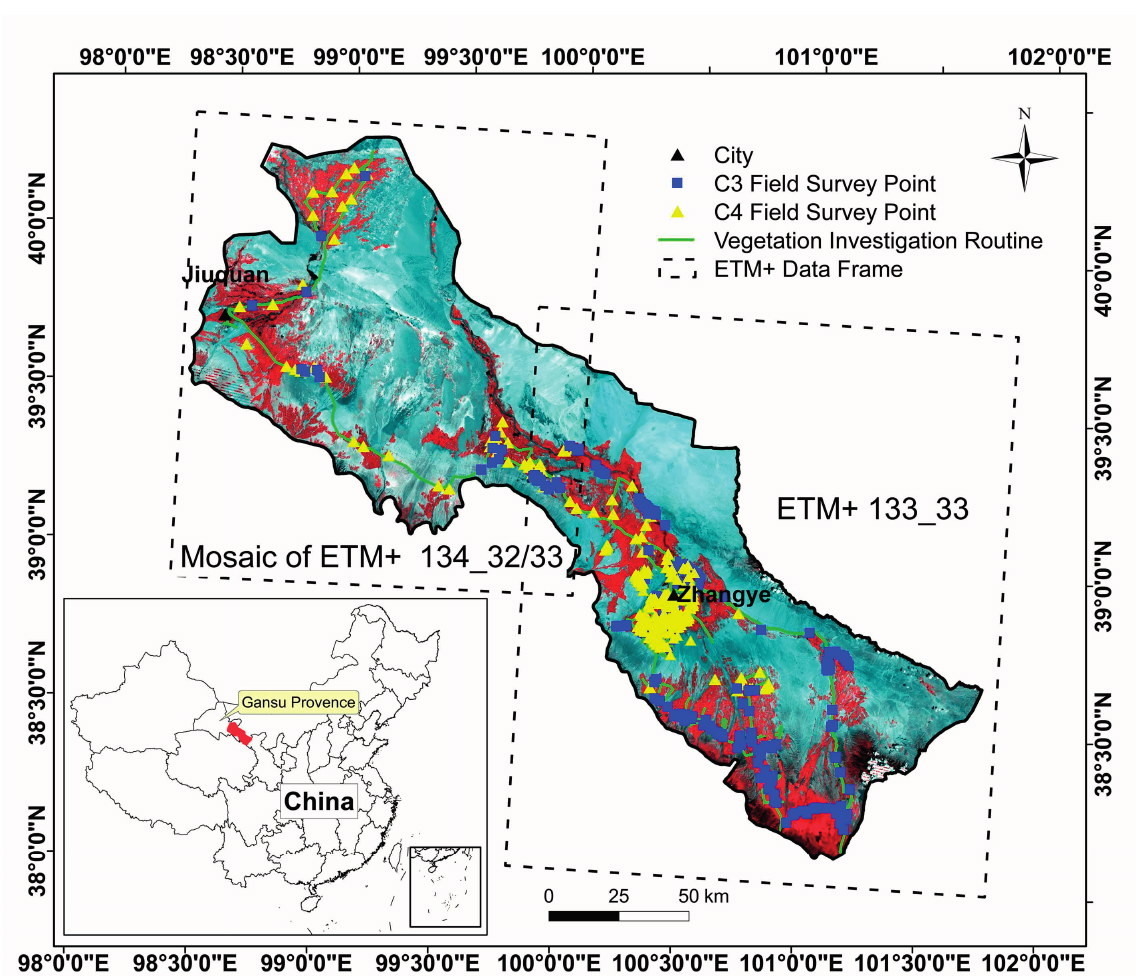
Figure 1. Location of the study area. The image is the false color composition of Landsat ETM+ data (R: band 4, G: band 3, B: band 2). The yellow triangles represent the field investigated C4 vegetation and the blue squares represent the C3 vegetation. The bright green line is the field vegetation survey